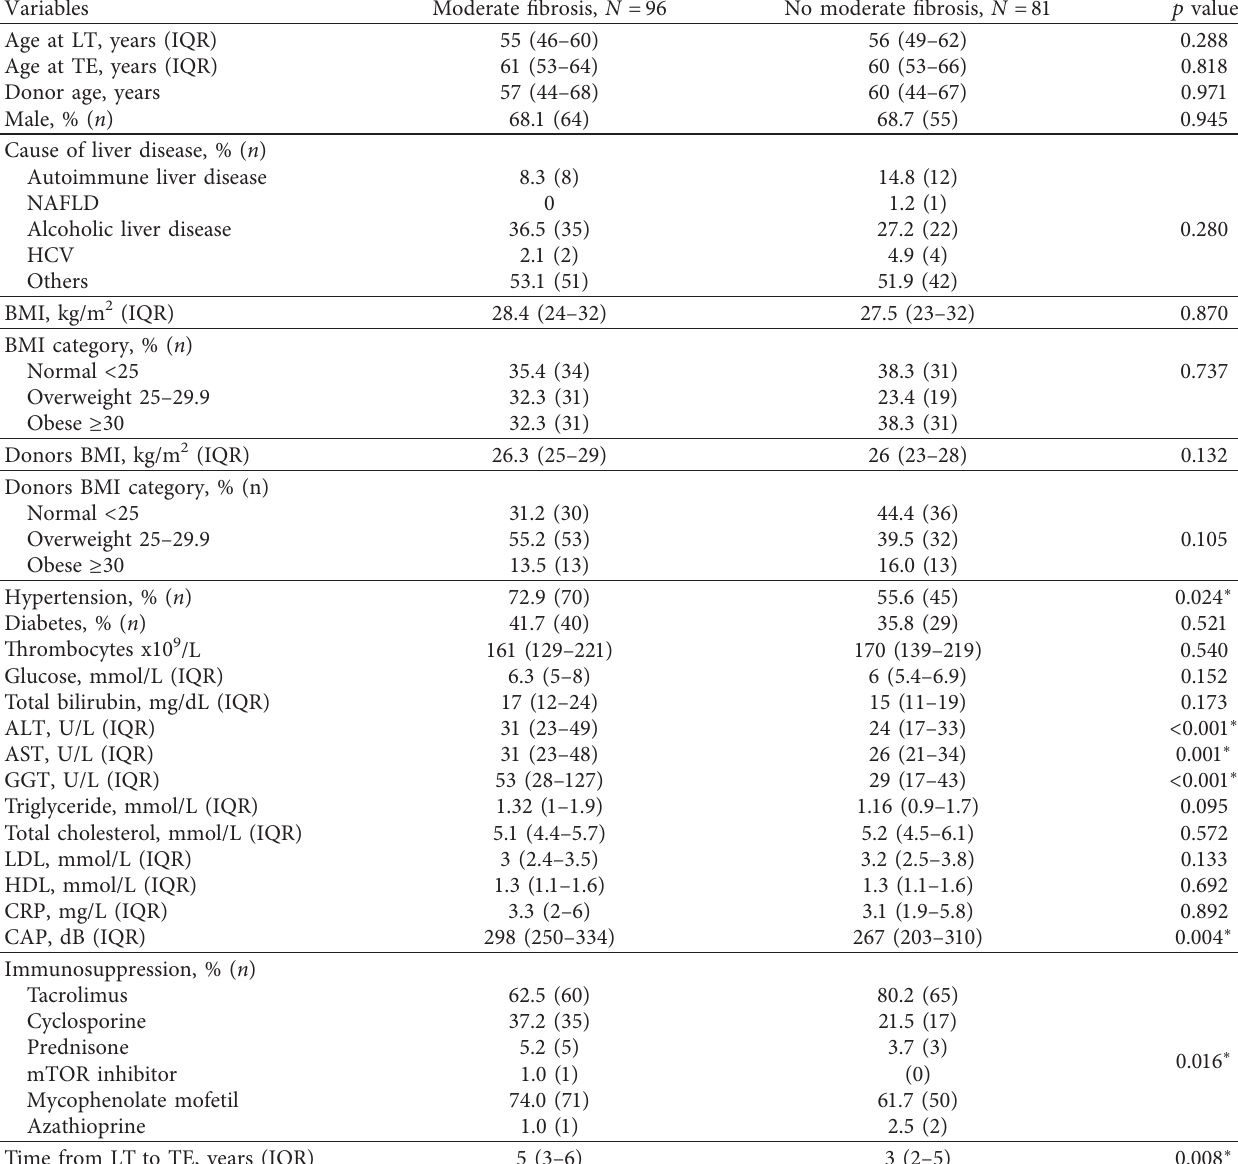
Table 5: Comparison of groups with and without moderate